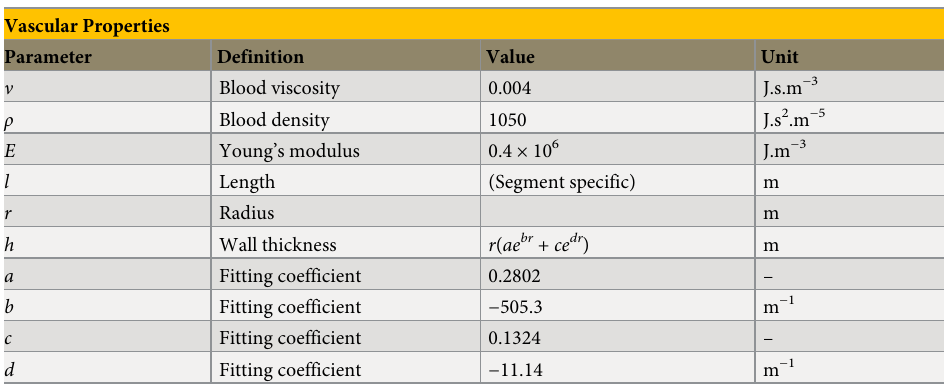
d m − 1 The wall thickness constants ( a , b , c , d ) are mathematical fitting parameters and are considered to be the same for all the